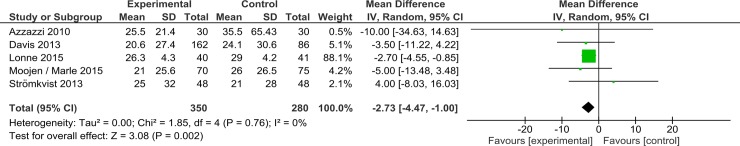
Comparison II (device versus decompressive surgery interventions), outcome VAS leg pain.Pooled data favors IPD, but the difference was not clinically significant.